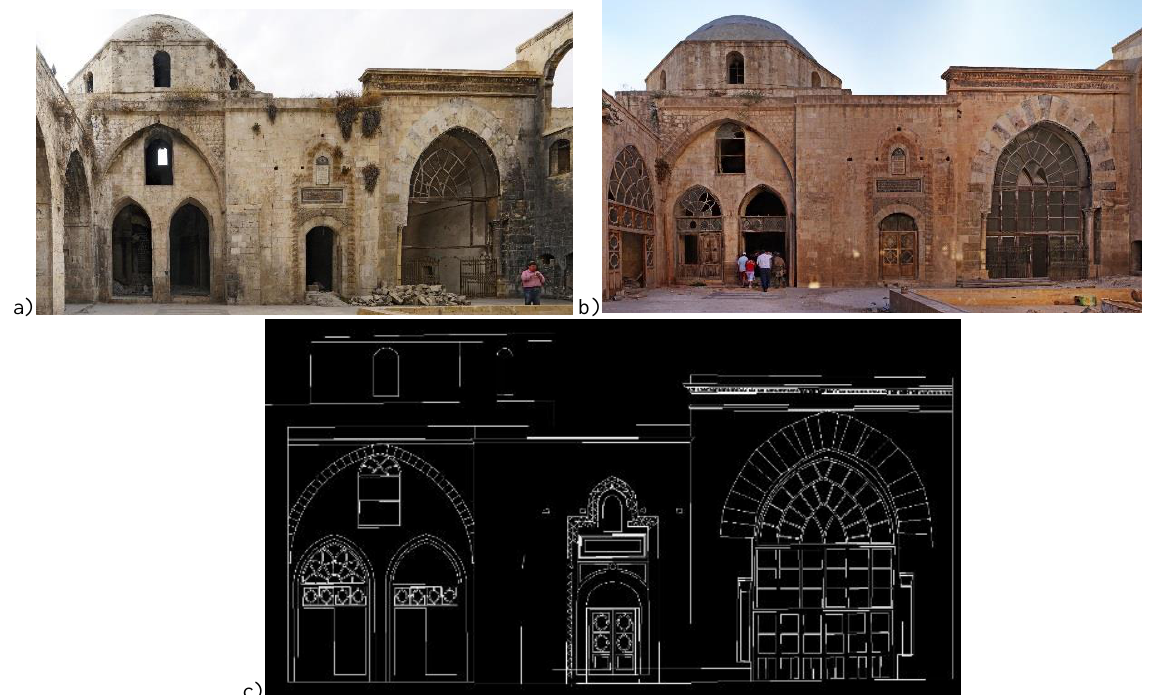
Figure 8: Al Haways medrasa, current situation (a), how it was in 2010 (b) and 3D restitution (c) by F.Di Stefano.